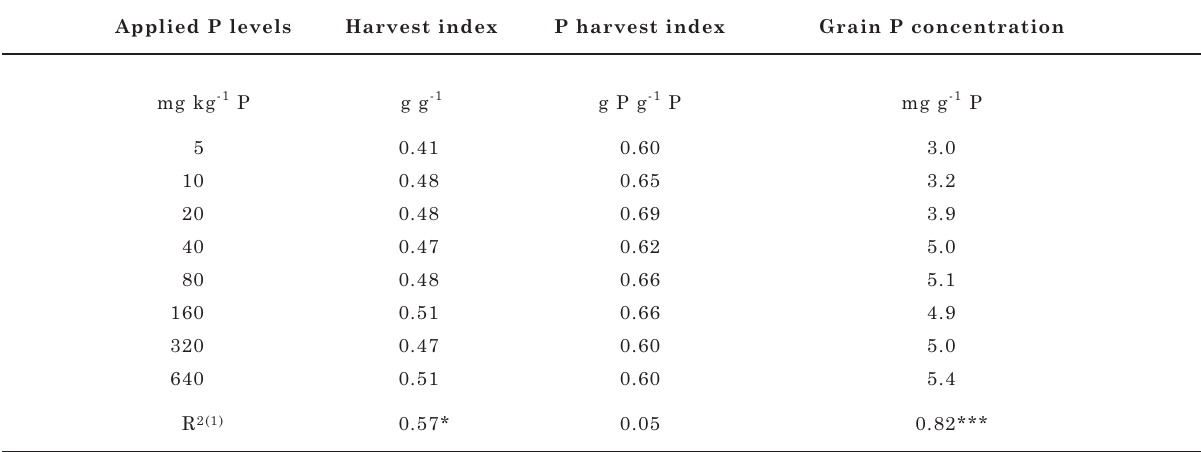
Table 1. Harvest index (ratio between seed and above-ground dry mass), P harvest index (ratio between P content in seed and in above-ground biomass), and grain P concentration at maturity, of common bean plants grown at eight P levels applied to the